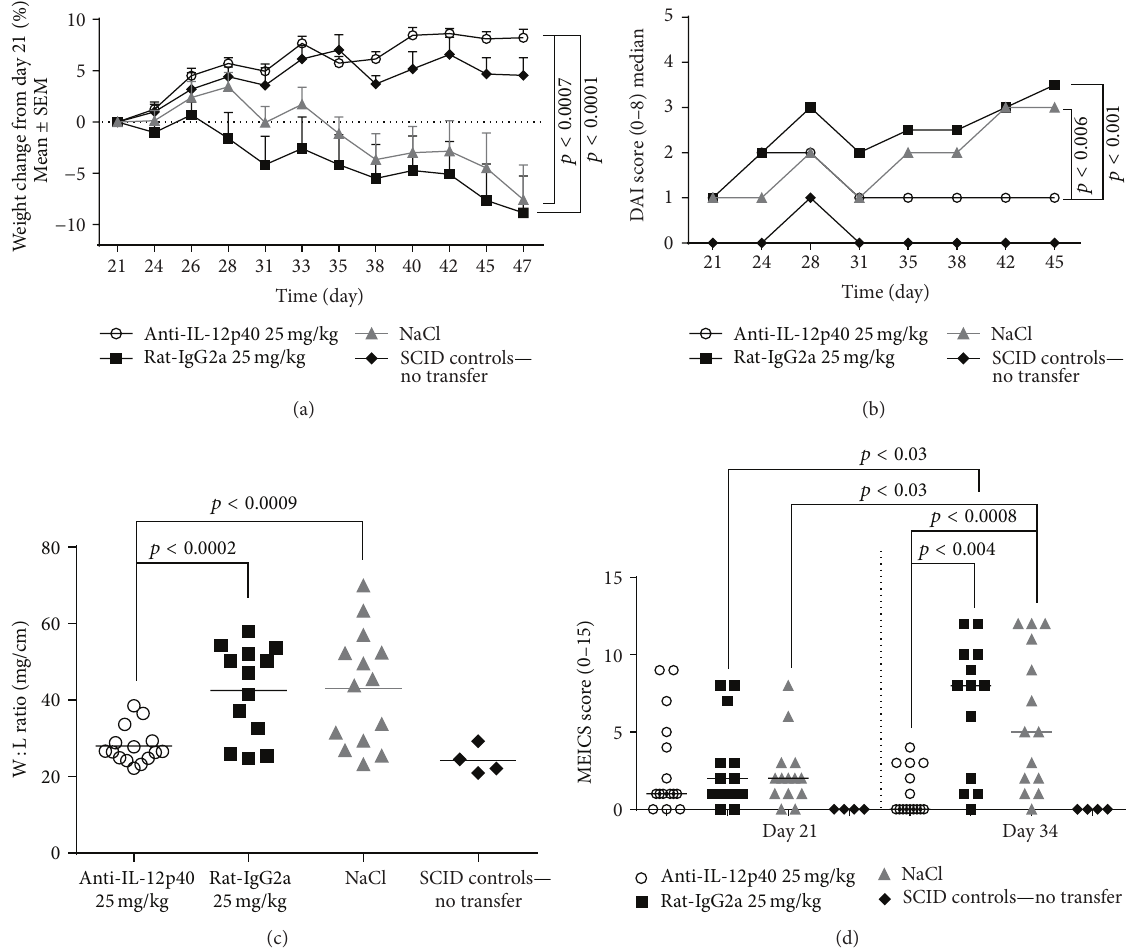
Figure 1: Induction of AdTr-colitis is associated with weight loss, loose stools, and colonic inflammation. (a) Delta weight loss from day 21 is shown as mean ± SEM for individual groups. Significant differences between the areas under the curve (AUC) for individual mice were determined by Student’s 𝑡 -test. (b) DAI was determined with a combined scale from 0 to 8 by combining weight loss (0–4) and stool score (0–4). Differences in DAI scores were calculated as AUC for individual mice from 21 to 45 days using Mann-Whitney 𝑈 test. (c) The colon weight- (mg) to-length (cm) ratio was calculated for individual mice. Comparisons between groups were performed using Student’s 𝑡 -test. (d) Endoscopic analysis of colon at 21 and 34 days was graded with MEICS. All mice were scored semiquantitatively in a blinded fashion. Significant differences were determined with Mann-Whitney 𝑈 test for unpaired analysis and Wilcoxon for paired